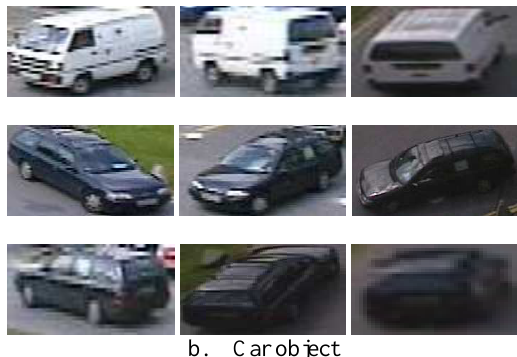
Figure 11: Some objects with different observation angles [14]